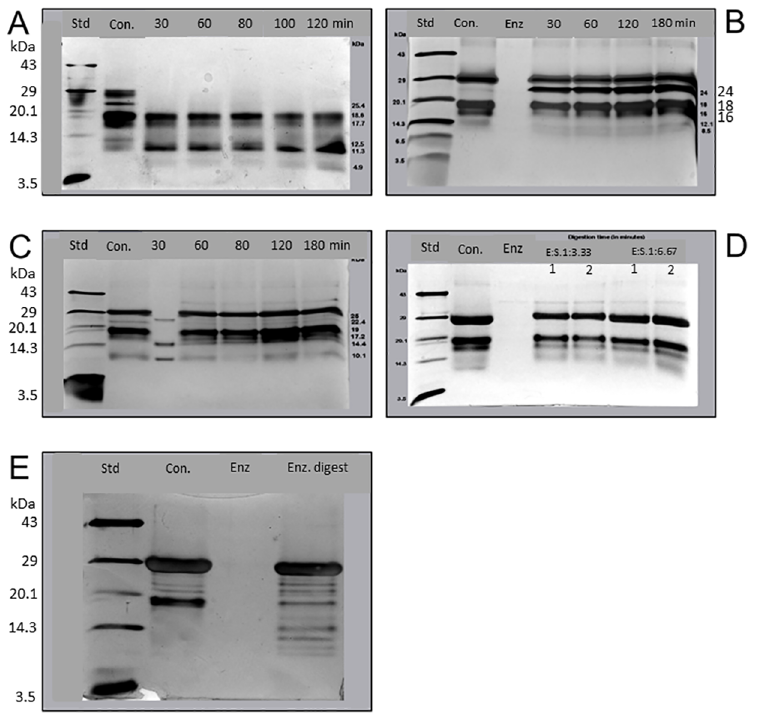
Fig 1. Analyzes on enzyme digests. (A) Tricine SDS-PAGE (14%) of T . cordifolia stem proteins treated with papain enzyme. Lane 1, marker (GeNei low molecular weight); lane 2, protein not treated with enzyme; lanes 3 to 7, protein treated with papain enzyme for different time intervals of 30 to 120 minutes; (B) Tricine SDS-PAGE (14%) of T . cordifolia stem proteins treated with trypsin enzyme. Lane 1, marker (GeNei low molecular weight); lane 2, protein not treated with an enzyme; lanes 3 to 7, protein treated with trypsin enzyme for time intervals of 30 to 120 minutes; (C) Tricine SDS-PAGE (14%) of T . cordifolia stem proteins treated with the α -chymotrypsin enzyme. Lane 1, marker (GeNei low molecular weight); lane 2, protein not treated with an enzyme; lanes 3 to 7, protein treated with the α - chymotrypsin enzyme for different time intervals of 30 to 120 minutes; (D) Tricine SDS-PAGE (14%) of T . cordifolia stem proteins treated with pepsin enzyme with silver staining. Lane 1, marker (GeNei low molecular weight); lane 2, protein not treated with the enzyme; lane 3, enzyme alone; lanes 4 to 7, protein treated with pepsin enzyme for different time intervals of 60 and 120 minutes, with two different enzyme:protein ratios of 1:3.33 and 1:6.67 (wt/wt); (E) Tricine SDS-PAGE (14%) of T . cordifolia stem proteins treated with pepsin-pancreatin enzymes with silver staining. Lane 1, marker (GeNei low molecular weight); lane 2, protein not treated with an enzyme; lane 3, enzyme alone; lane 4, protein treated with pepsin-pancreatin enzyme for 2 and 4